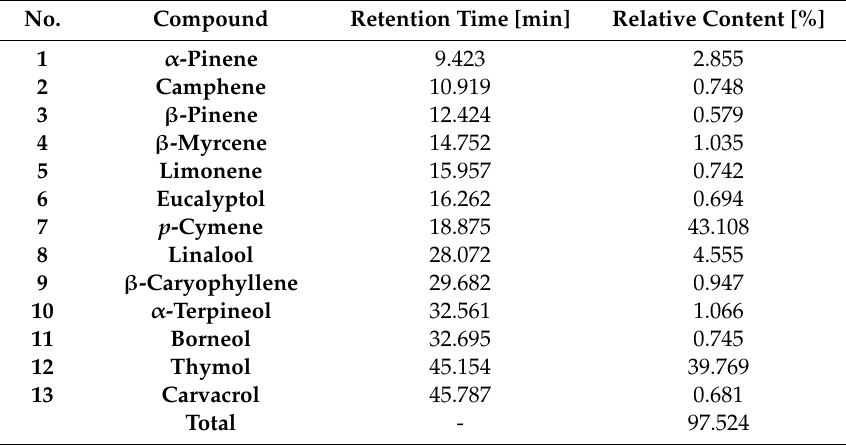
Table 7. Relative abundance of major compounds of T. vulgaris essential